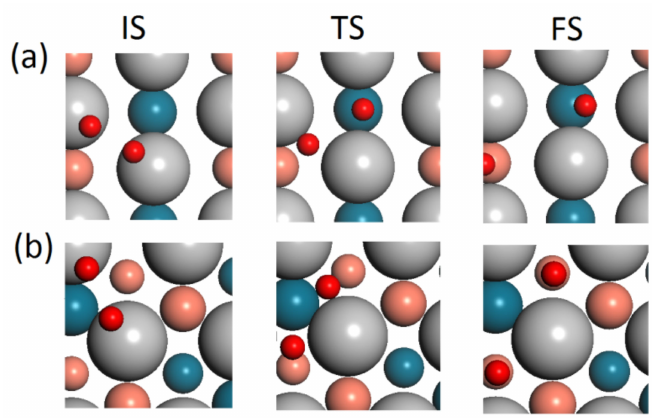
Figure 4. The top view of selected states along the path of O 2 dissociation for ( a ) intermetallic Pd–Cu Pd/Pd–Cu(110) and ( b ) Pd–Cu FCC alloy